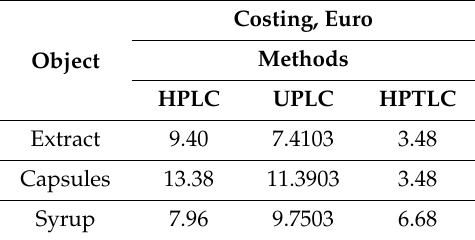
Table 10. Cost of analytical research of HPLC, UPLC, HPTLC for various